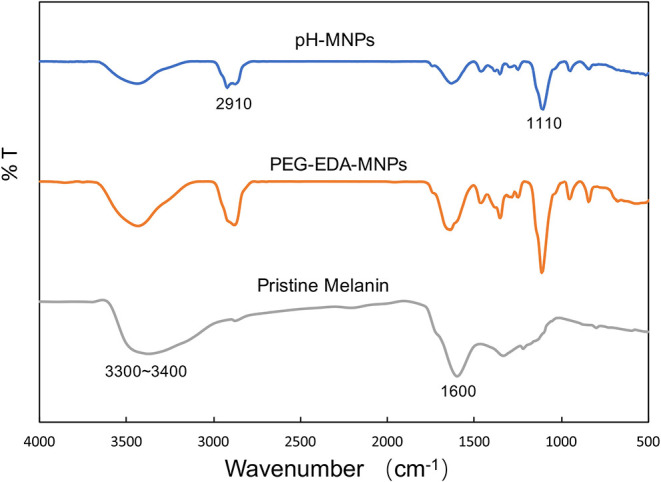
FT-IR spectra of pristine melanin, PEG-EDA-MNPs, and pH-MNPs.